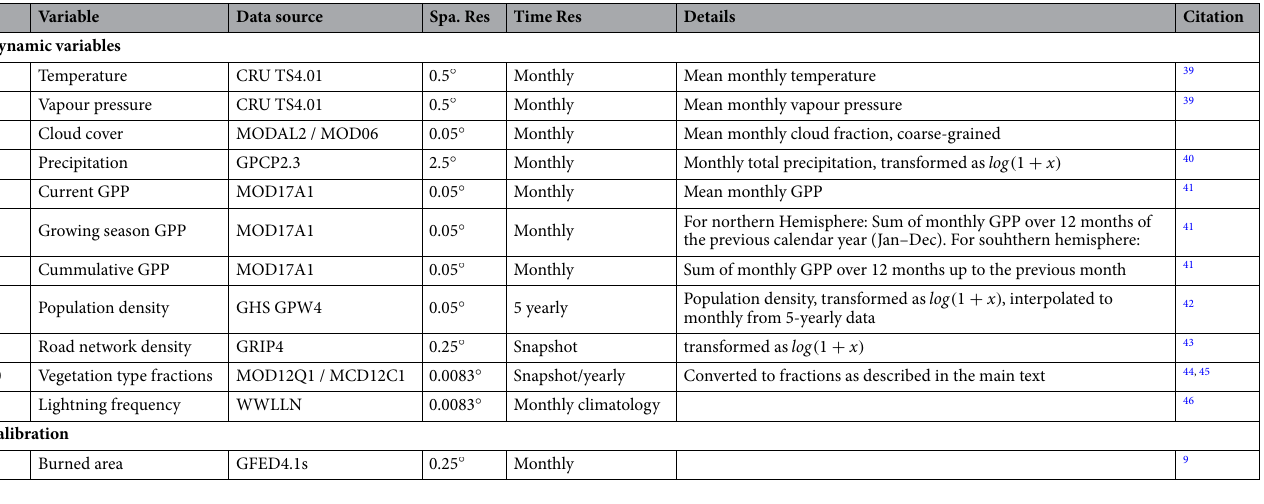
Table 1. Gridded datasets used and their